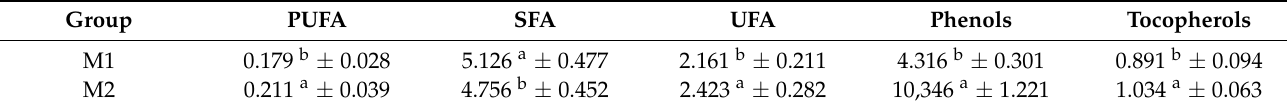
Table 7. Effect of dried destoned virgin olive pomace (DDVOP) on the chemical characteristic of sheep milk. The values (mean ± SD) are expressed as a percentage for acid composition and mg/kg for phenols and tochopherols. M1—milk from sheep fed unaltered feed; M2—milk from sheep fed feed enriched with DDVOP; PUFA—polyunsaturated fatty acids; SFA—saturated fatty acids; UFA —unsaturated fatty acids. Different letters indicate statistical differences as per p < 0.05.